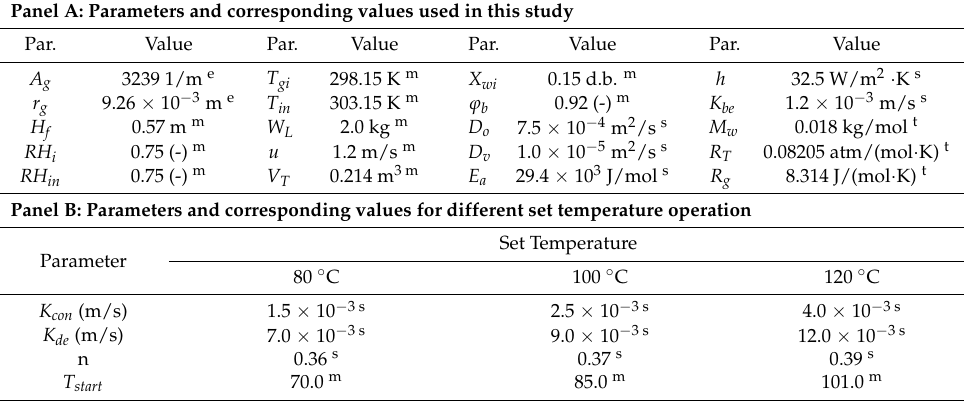
Table 3. Input parameter values.